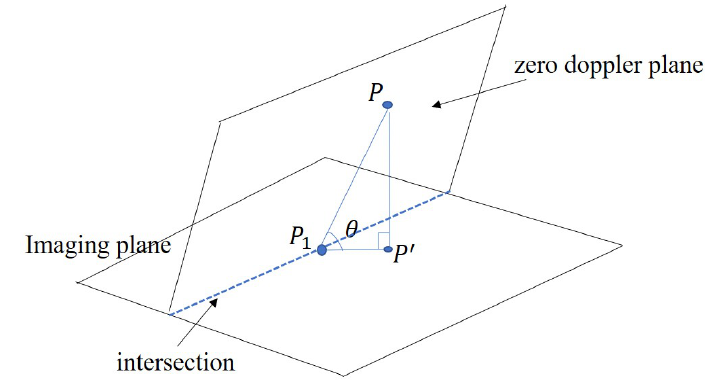
Figure 4. Schematic diagram of equivalent incidence angle.